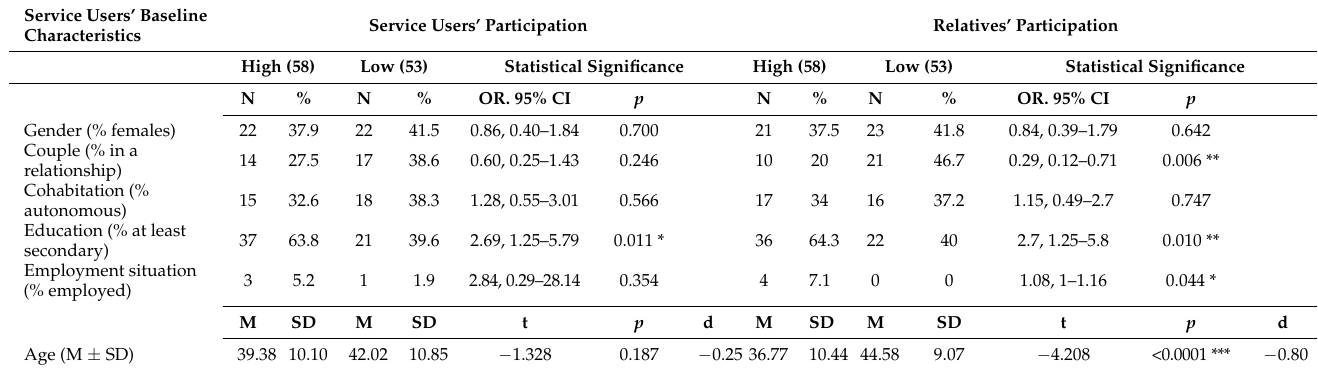
Table 1. Sociodemographic characteristics of service users recruited into the study by level of participation of both groups.